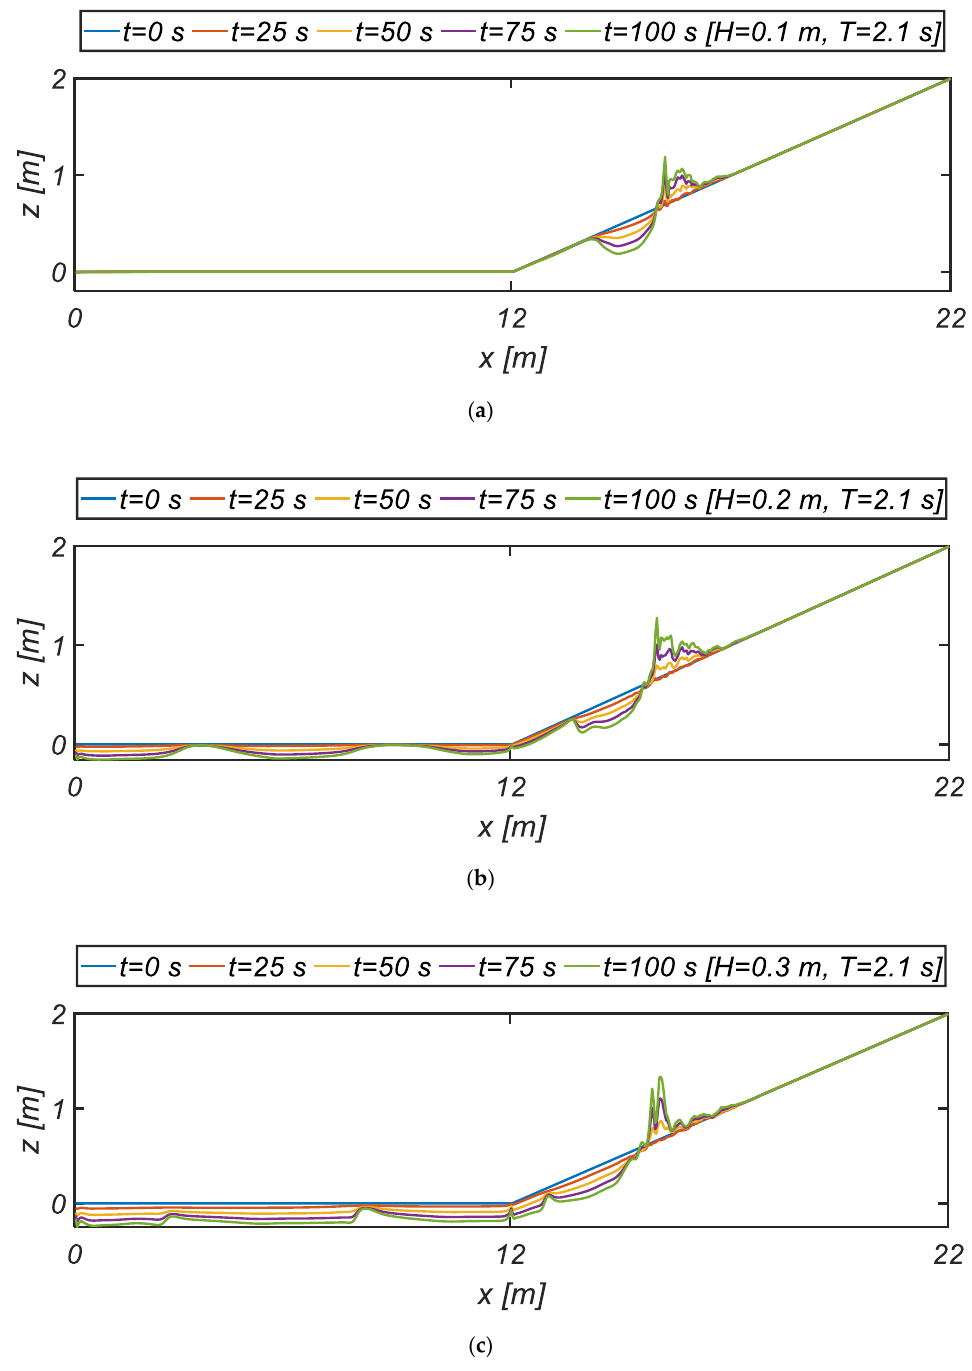
Figure 14. Evolution of beach profile as the number of attacking waves is accumulated. ( a ) RUN 1; ( b ) RUN 2; ( c ) RUN 3.